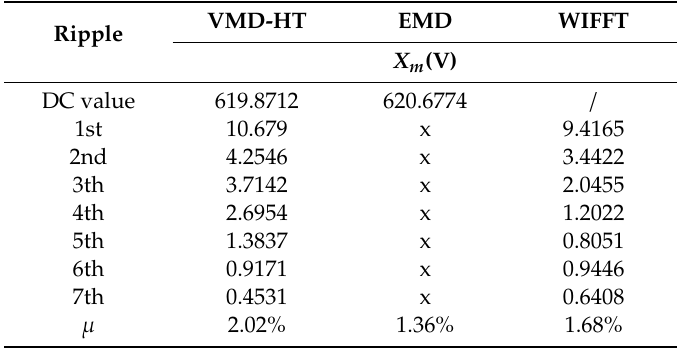
Table 9. Ripple components comparison among three